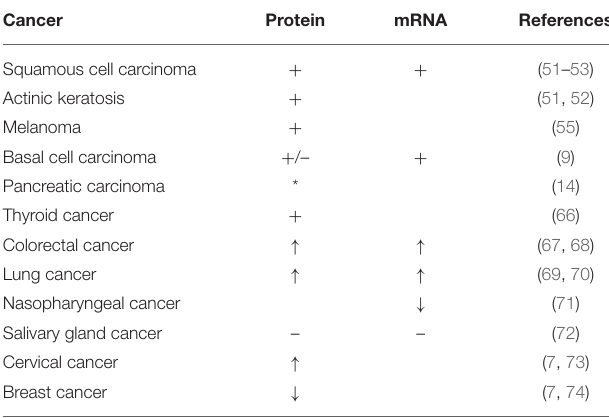
TABLE 1 | Collagen XVII as it pertains to cancer